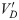
Alternative parameterizations capture the majority of genetic variance.Using an alternative parameterization that emphasizes dominant gene action, a newly defined dominance variance VD′ and additive deviation variance VA′ are estimated analytically under dominant (a) and additive (b) models. Using an alternative parameterization that emphasizes additive by additive gene action, a newly defined interaction variance VAA′′ is estimated numerically under additive by additive (c) and additive (d) models.